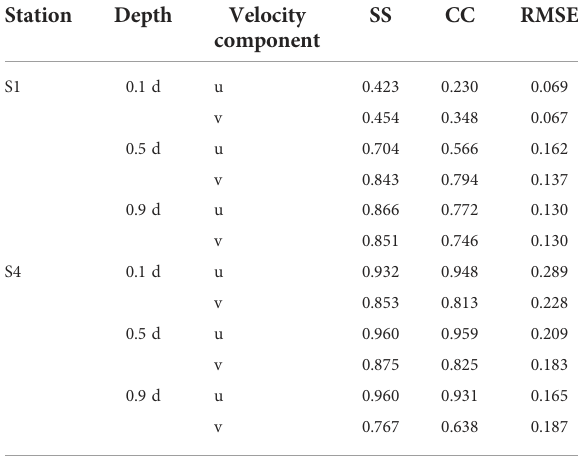
TABLE 3 The model-data comparisons of tidal current. Station